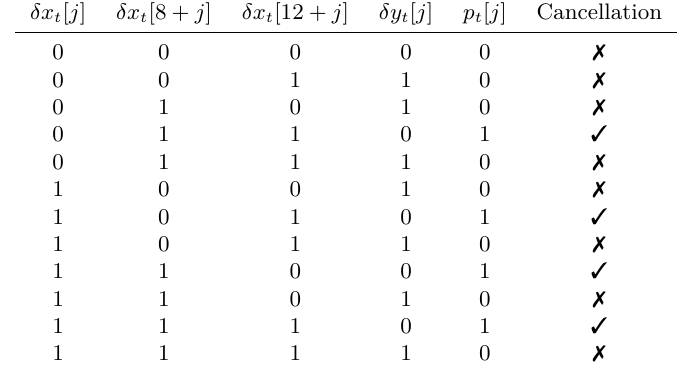
Table 5: All valid valuations of ( δx t [ j ] , δx t [4 + j ] , δx t [8 + j ] , δx t [12 + j ] , δy t [ j ] , p t [ j ])